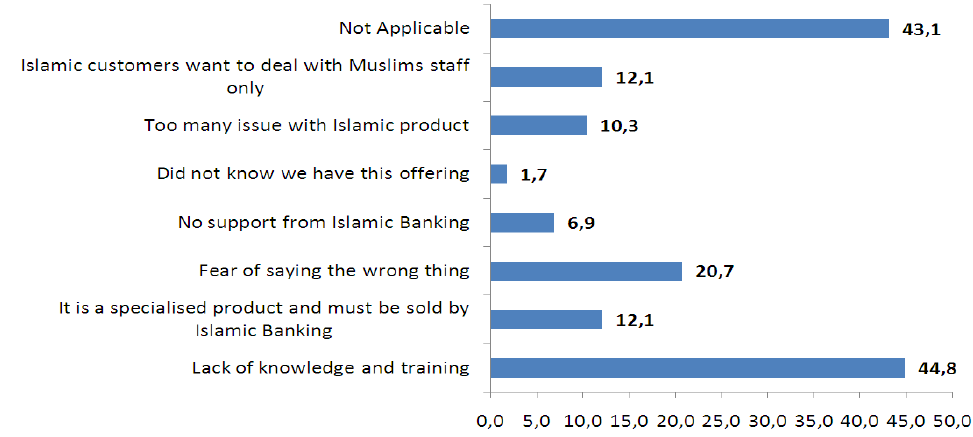
Fig. 5. Reasons for not being comfortable regarding Islamic